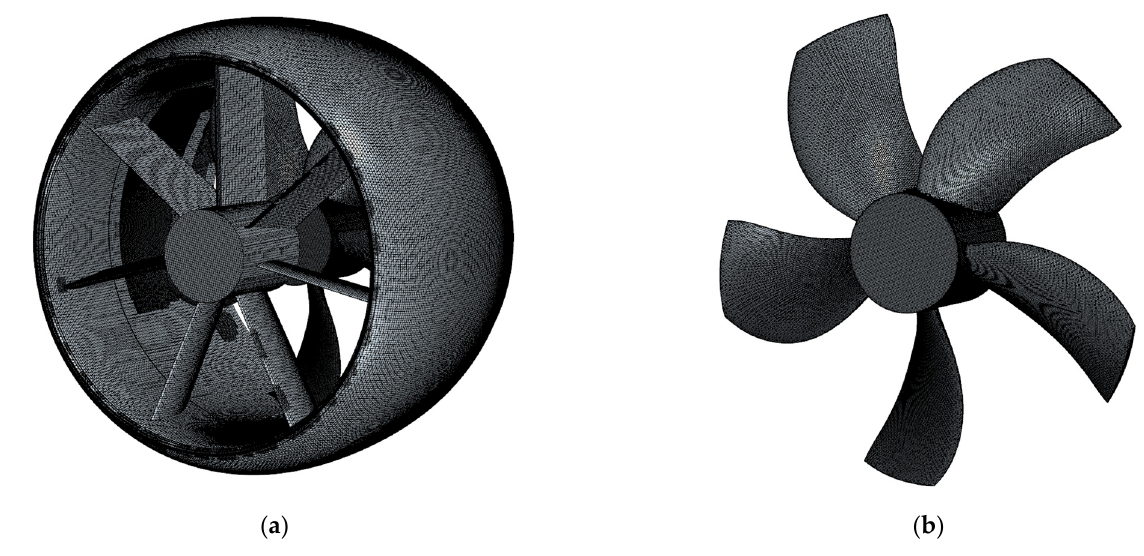
Figure 11. Schematic diagram of the surface mesh of the pump-jet: ( a ) Schematic diagram of front stator and conduit mesh; ( b ) Rotor grid diagram.